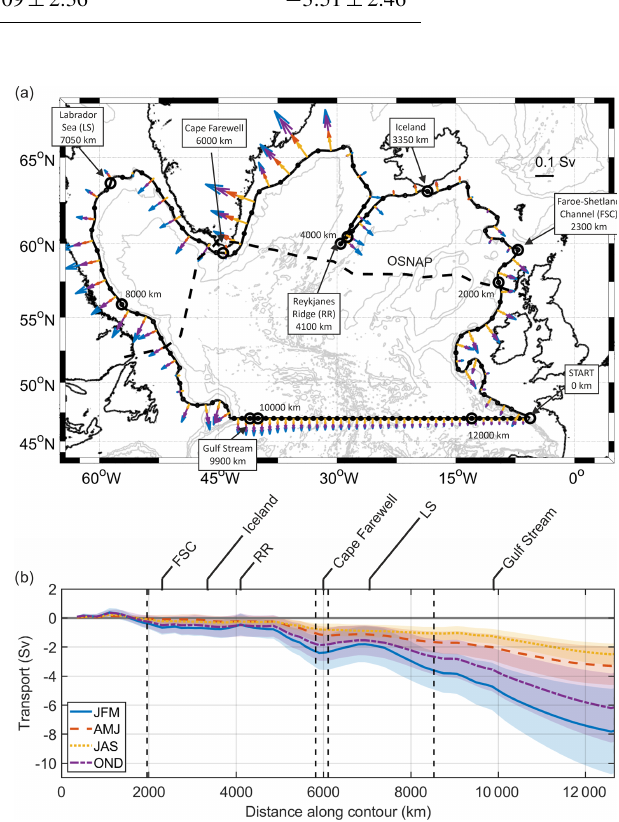
Figure 5. Geostrophic transport perpendicular to contour; positive values denote transport into the SPG. (a) Depth-integrated vol- ume transport between 0 and 1000m for each grid cell (time se- ries and annual mean). Quiver arrows show the magnitude of trans- port across grid cell and are constrained to be perpendicular to the section. Horizontal bins are 150km apart around the 1000m con- tour and 1 ◦ across 47 ◦ N. Bathymetry contours from are General Bathymetry Chart of the Oceans (GEBCO, http://www.gebco.net/, last access: 15 June 2020). (b) Cumulative volume transport around basin for each season. Key locations around boundary labelled as in Fig. 3, and vertical dashed lines denote OSNAP crossings.